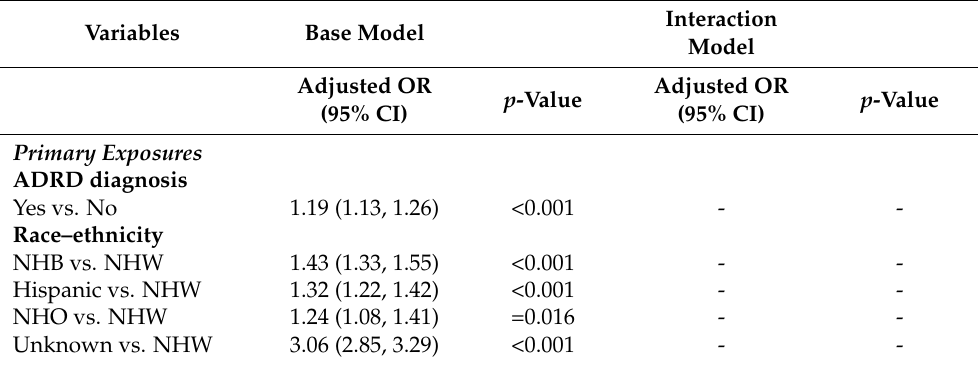
Table 3. Multivariable logistic regression estimating the association between ADRD diagnosis and mammography use in women aged 50–73 in